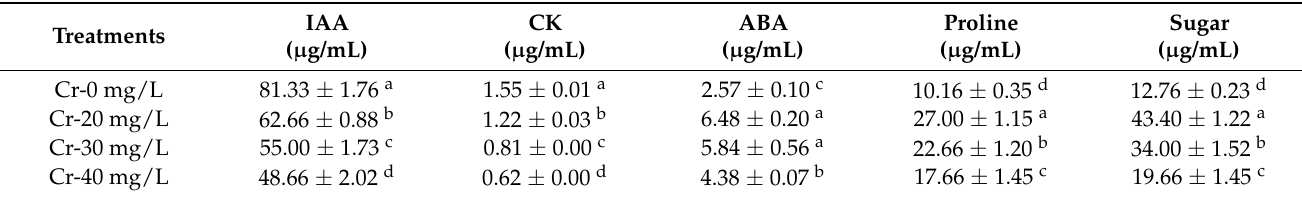
Table 1. Effect of chromium stress on phytohormones and osmolytes production by Bacillus cereus grown in the culture medium.